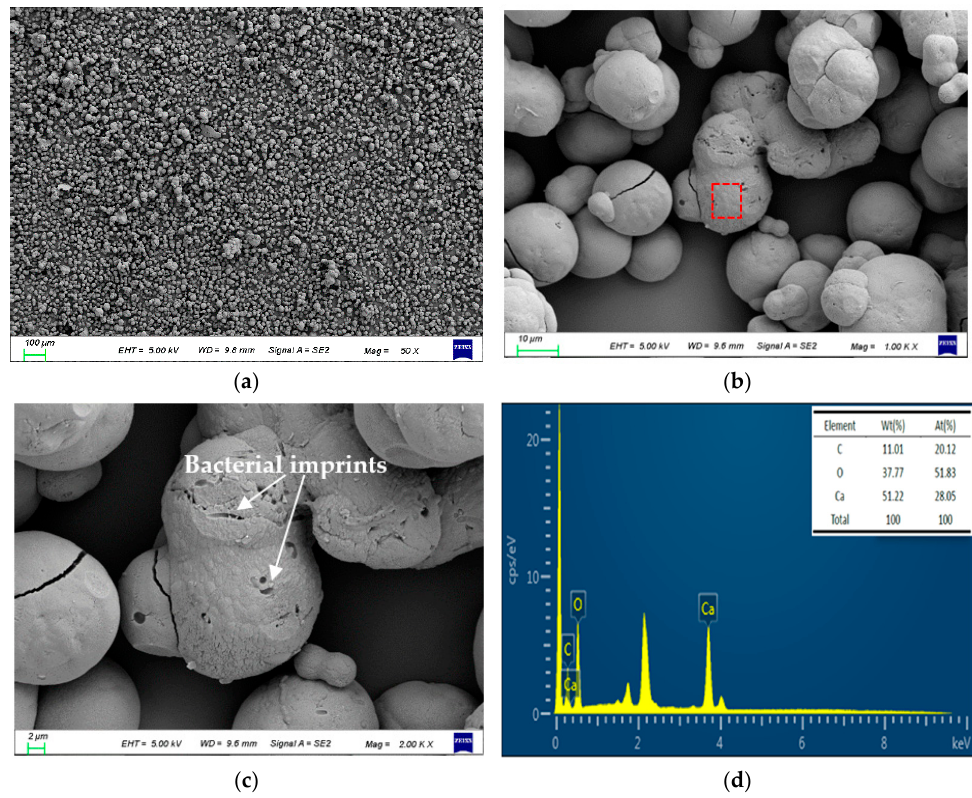
Figure 5. SEM images and EDS spectrum of bioprecipitations scraped from treated RFA: ( a ) at 50× magnification; ( b ) at 1000× magnification; ( c ) at 2000× magnification; ( d ) EDS spectrum of bioprecipitations in the red rectangle in image ( b ).